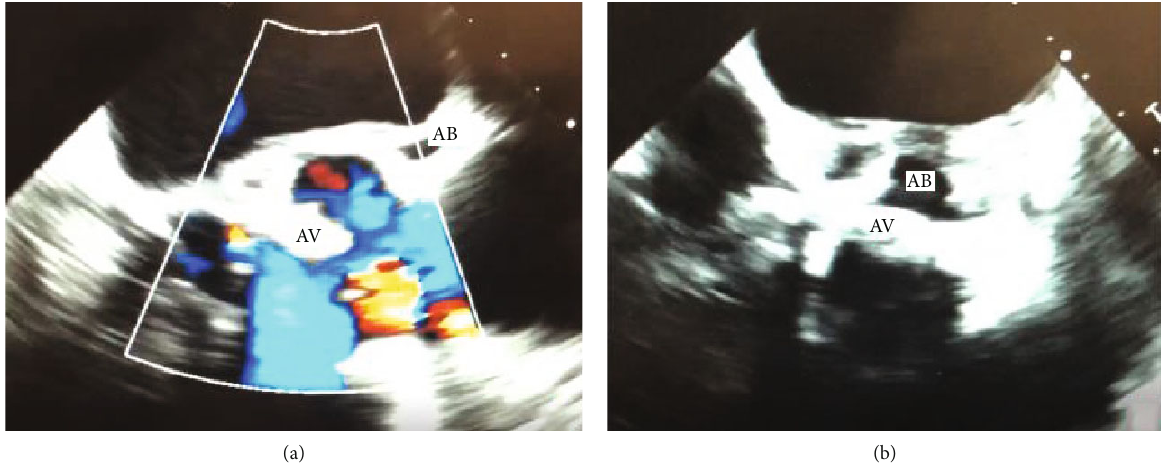
Figure 1: (a, b) Transesophageal echocardiogram showing aortic valve endocarditis (AV) and associated aortic root thickness and abscess. View in (a): color Doppler, apical long axis. View in (b): short-axis.